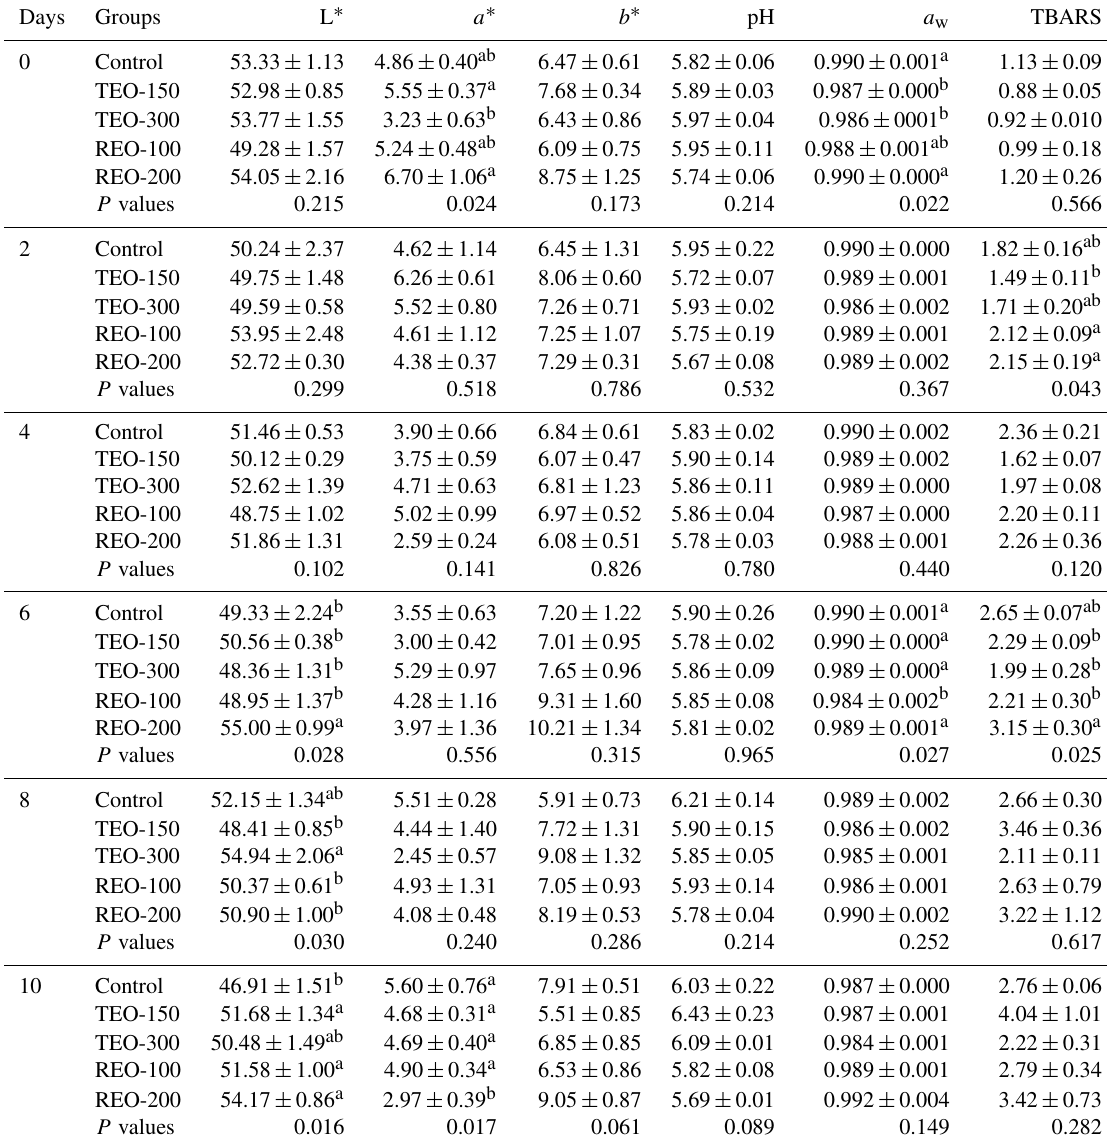
Table 5. Effects of dietary thyme and rosemary essential oils supplementation and storage period on colour parameters (L ∗ , a ∗ and b ∗ ), water activity, pH and TBARS in chicken breast